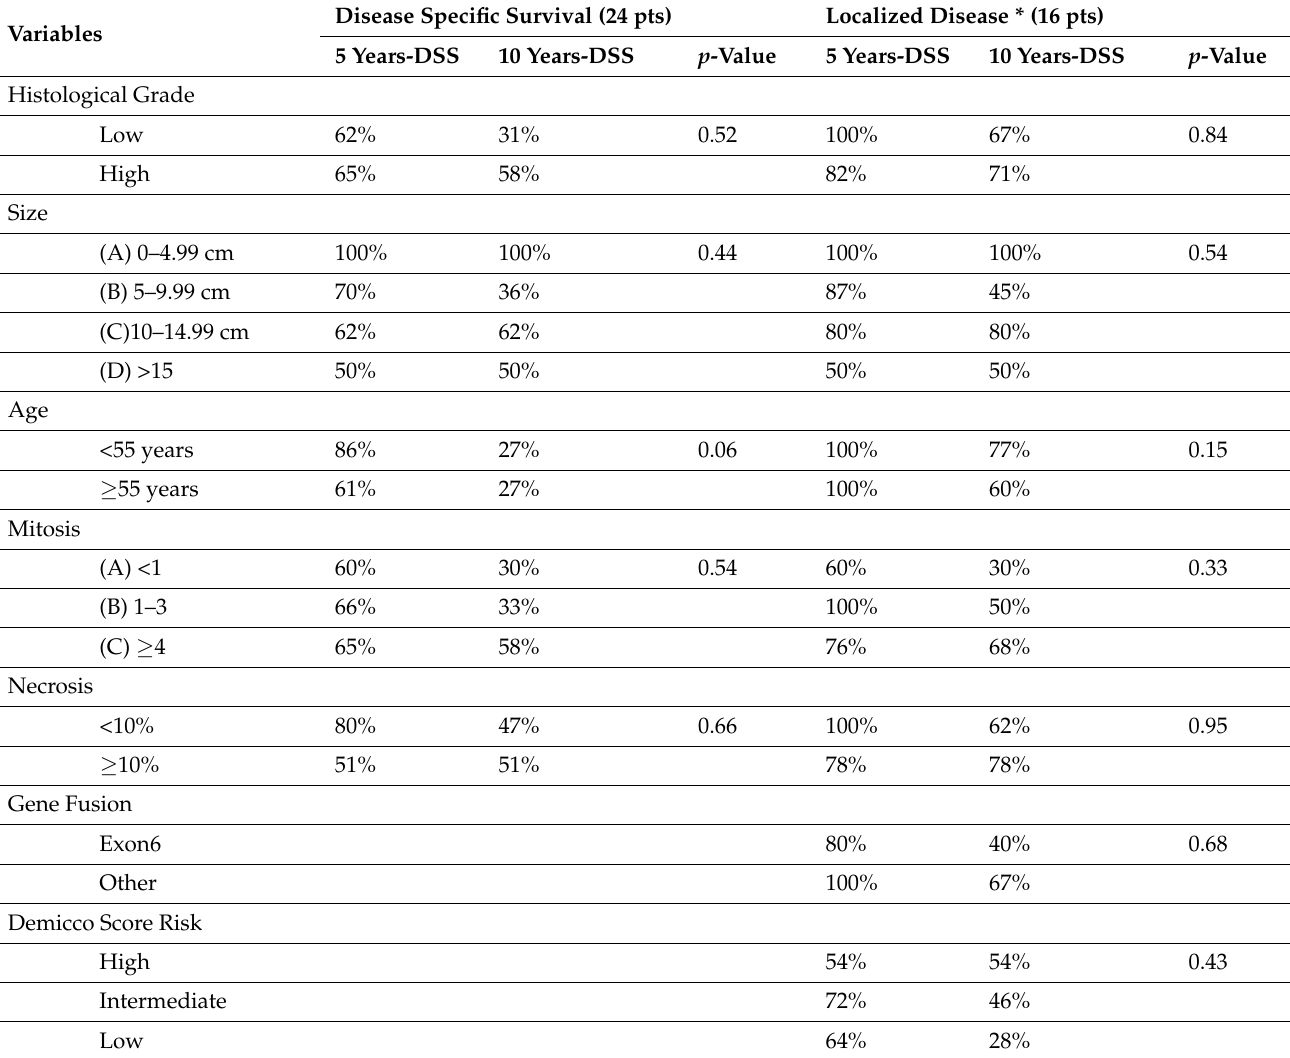
Table 3. Disease-specific survival (DSS) analysis related to clinicopathological